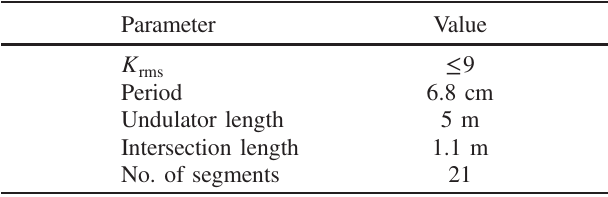
TABLE I. SASE3 undulator parameters.